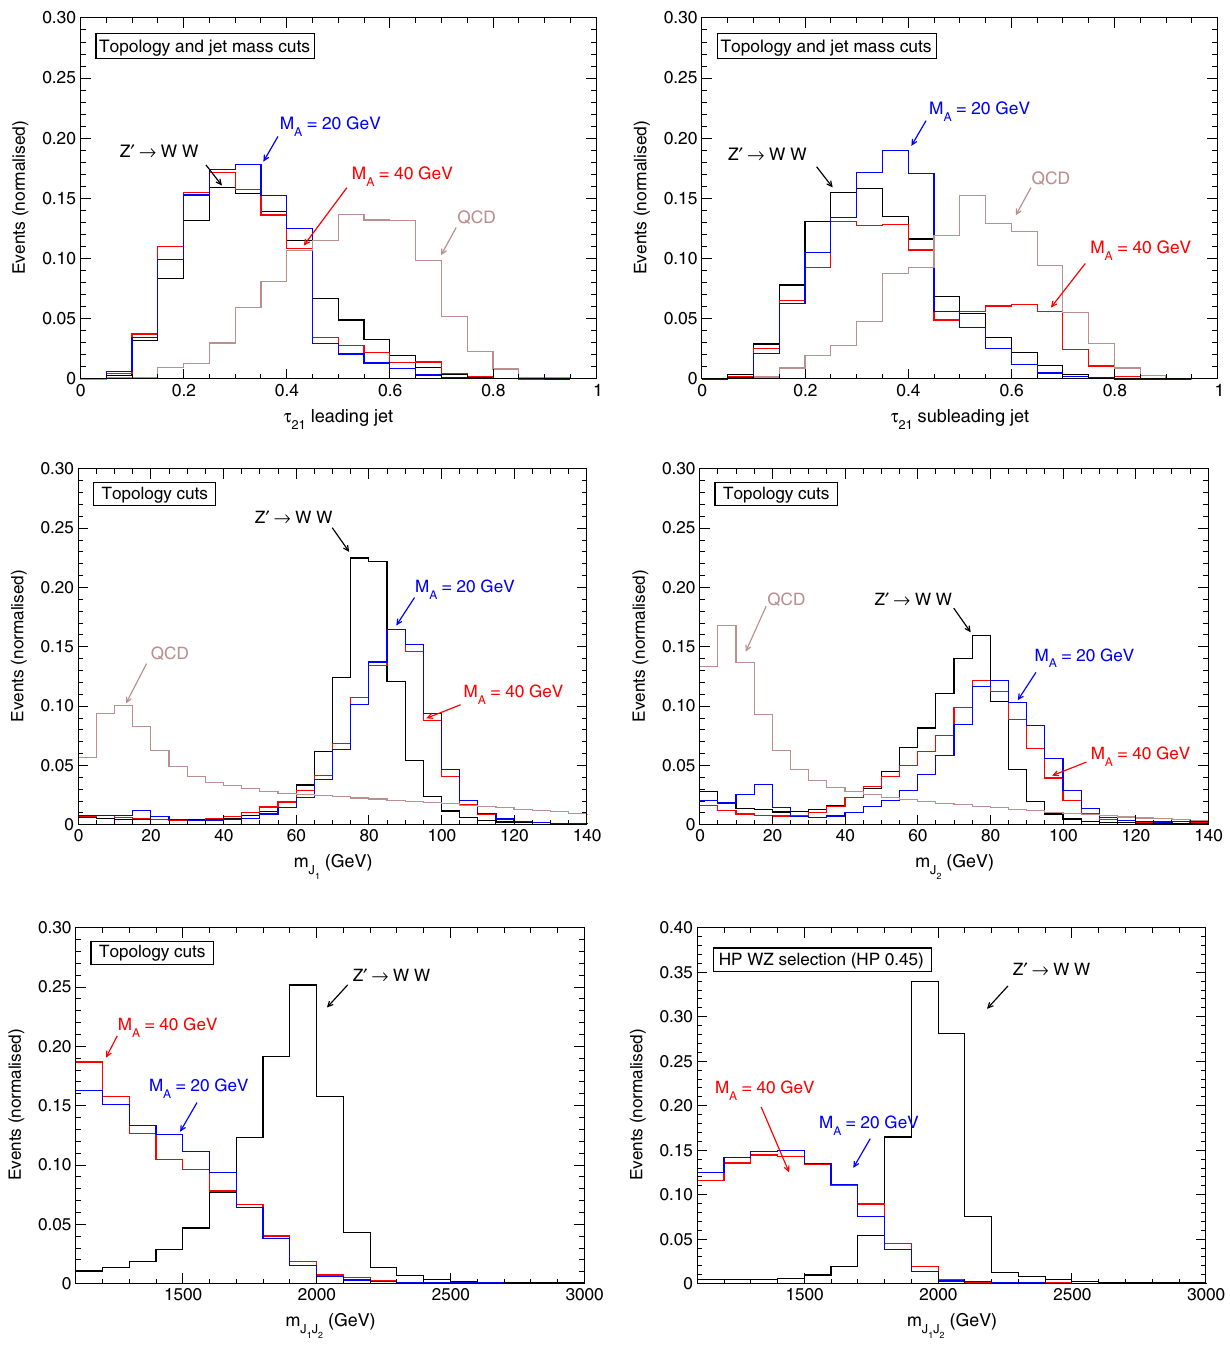
Fig. 12 Distributions for the R → V V S and Z (cid:8) → WW signals and the QCD dijet background in the CMS analysis. Top: N -subjettiness ratio τ 21 ; middle: jet mass distributions; bottom: dijet mass distributions